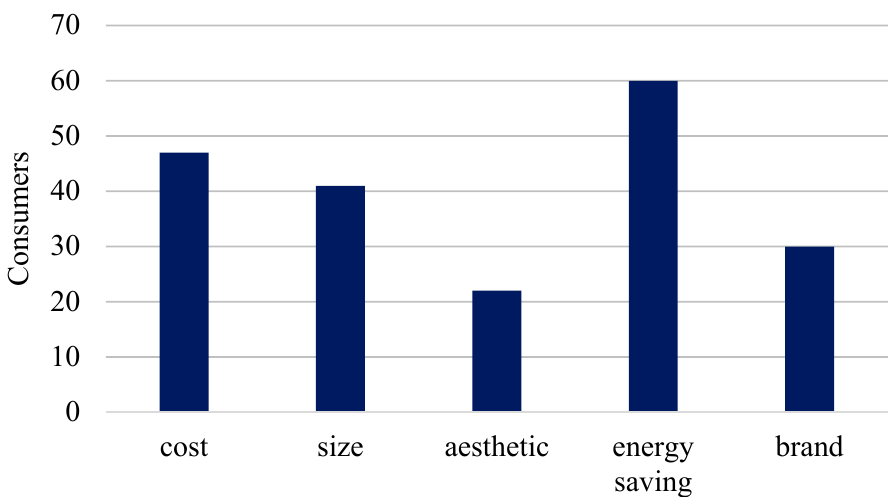
Figure 14. Consumers’ decision standards for buying a domestic refrigerator.